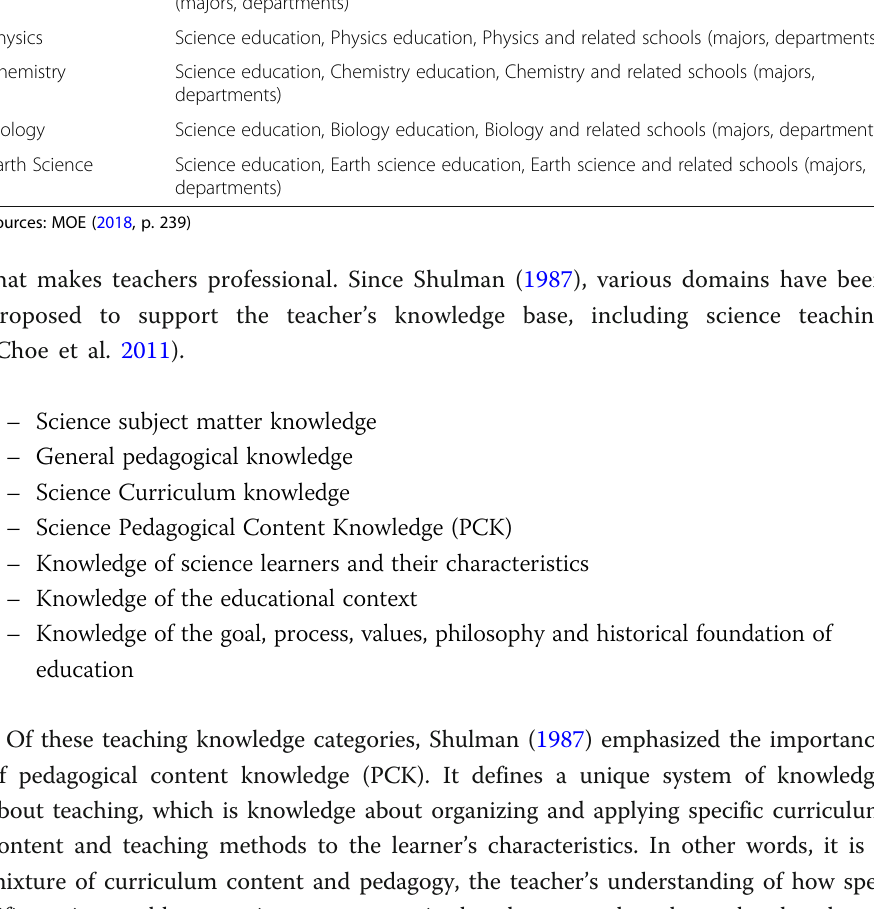
Table 2 Certification subjects and related schools (departments) Certification subjects Related schools (departments) Integrated